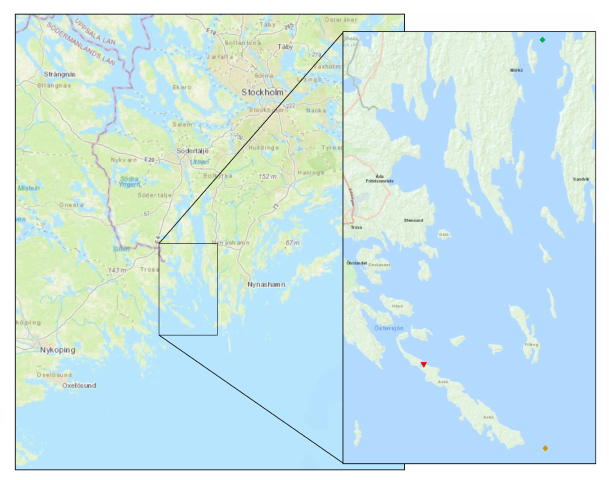
FIGURE 1 | Sampling location of pristine sediment (brown diamond) near the Askö laboratory (red inverted triangle), South-West at the border of Stockholm County. Amphipods and diatoms were collected at station H4 (green diamond). Map was adjusted from ÅN Austin (2019) and OpenSeaMap